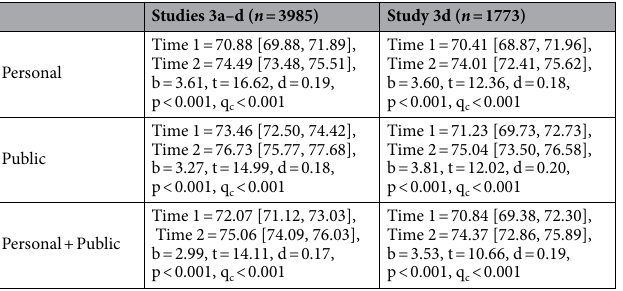
Table 4. Effectiveness of treatments in Study 3. For each treatment, we report mean Time 1 (i.e., pre- treatment) and Time 2 (i.e., post-treatment) prevention intentions, and the change over time (across Studies 3a–d, and in Study 3d